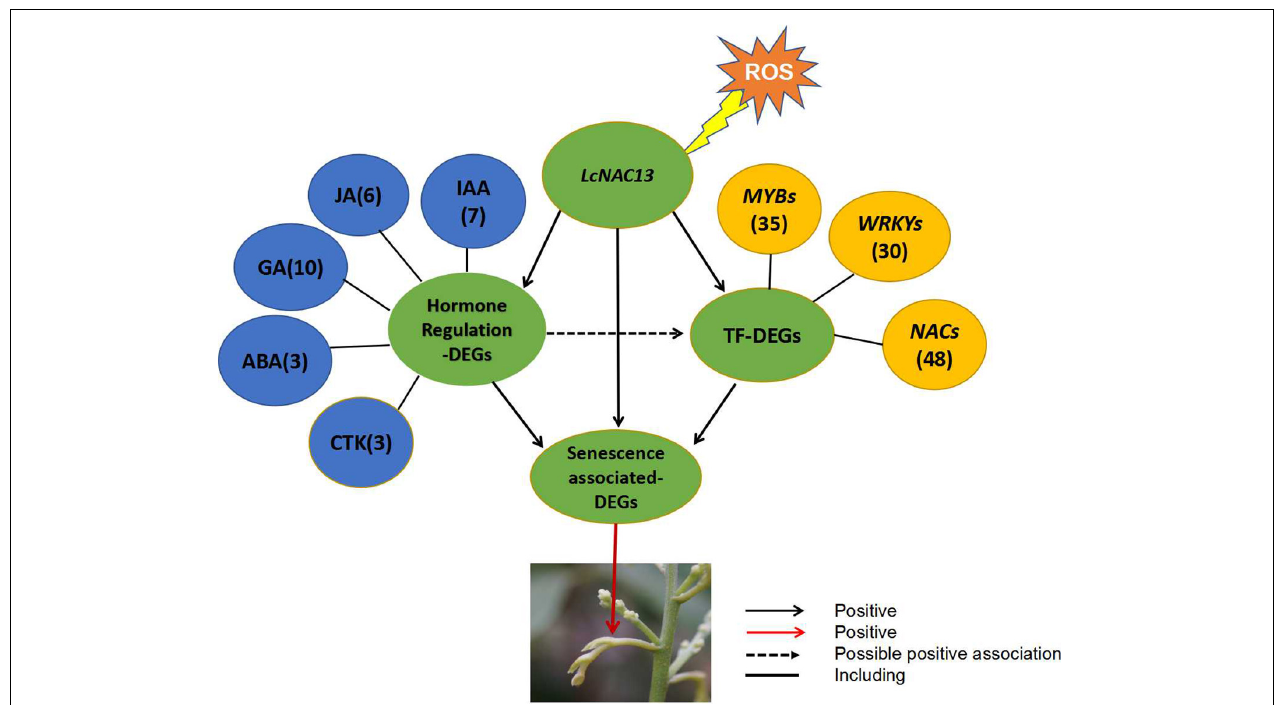
FIGURE 10 | A proposed model for the ROS-induced rudimentary leaf senescence regulated by LcNAC13. The numerals in the parentheses represent the number of differentially expressed genes. The relationship of the groups of the DEGs is shown in Figure 9 . The genes information inside the mapping is shown in Supplementary Figure 6